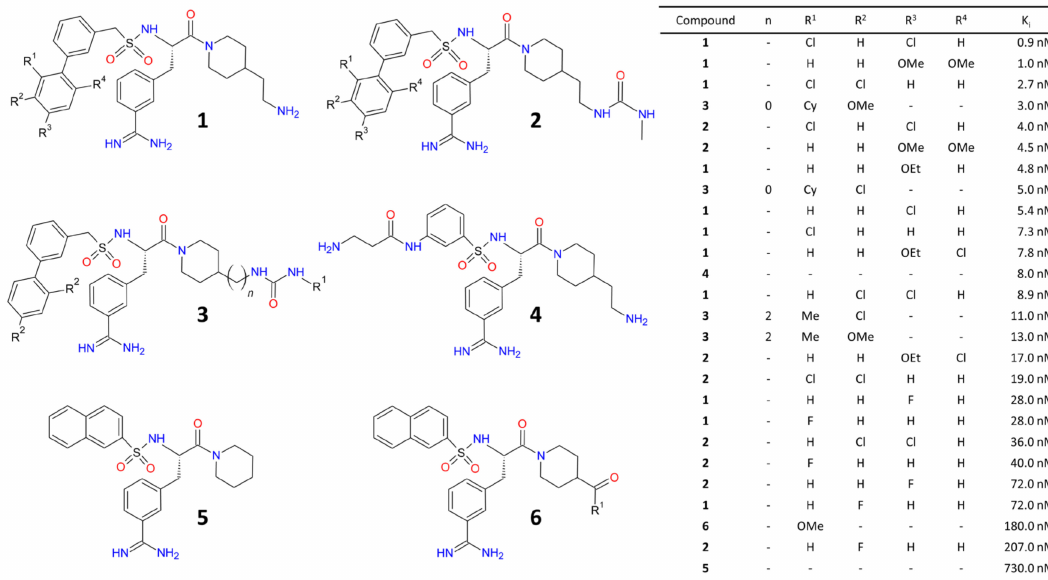
Figure 4. Structure–activity relationship of small molecule TMPRSS2 inhibitors. Shown are various synthetic inhibitors with sulfonylated 3-amindinophenylalanylamide moieties. For details and additional structures, see